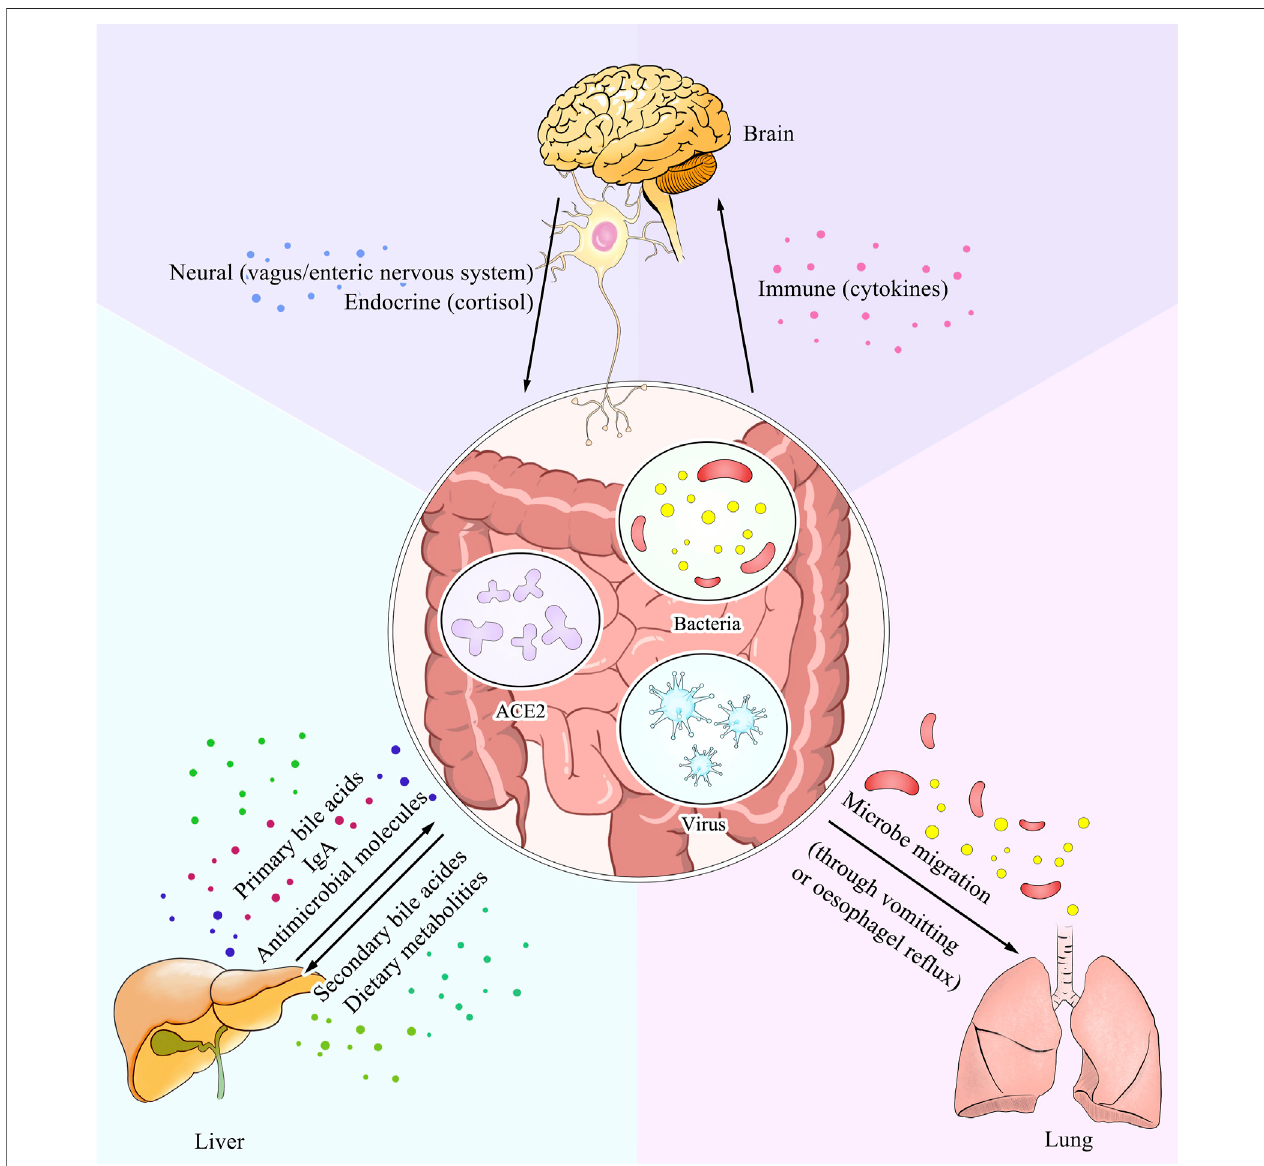
FIGURE 2 | ACE2 serves as a dominant link between the gut and other parts of the body. The expression level of ACE2 within the gut could interfere with the nutrient metabolism and result in alteration of the intestine microbes. Also as a pivotal ligand for the entry of SARS-CoV-2, it has an in fl uence on the virus concentration. Moreover, the soluble form of ACE2 could also transmit to other organs and lead to disturbance of the physical condition. All three ways mentioned above are shown in the picture with explanation of different pathways.